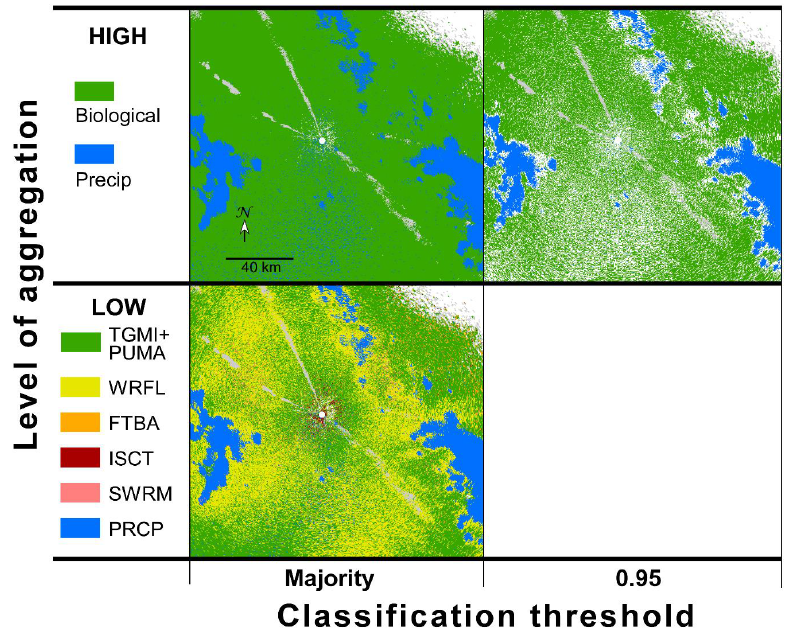
Figure 5. Areas where scatterer types mixed within resolution volumes reduced the probability of class membership and/or led to misclassification. Data from a single 0.5° elevation sweep on 9 May 2017 at 04:57 UT from the WSR-88D radar in Romeoville, IL (KLOT) classified according to two RF models built using high and low levels of aggregation. The panel of sweeps shows the distribution of resolution volumes at two different probabilistic classification thresholds, the majority classification, which depended on the number of classes (left), and those with probability of classification ≥0.95 (upper right; lower right intentionally left blank). Resolution volumes below this threshold were dropped and are shown as white space, often bordering precipitation. Pixels that did not have velocity data were not classified by our models and are colored